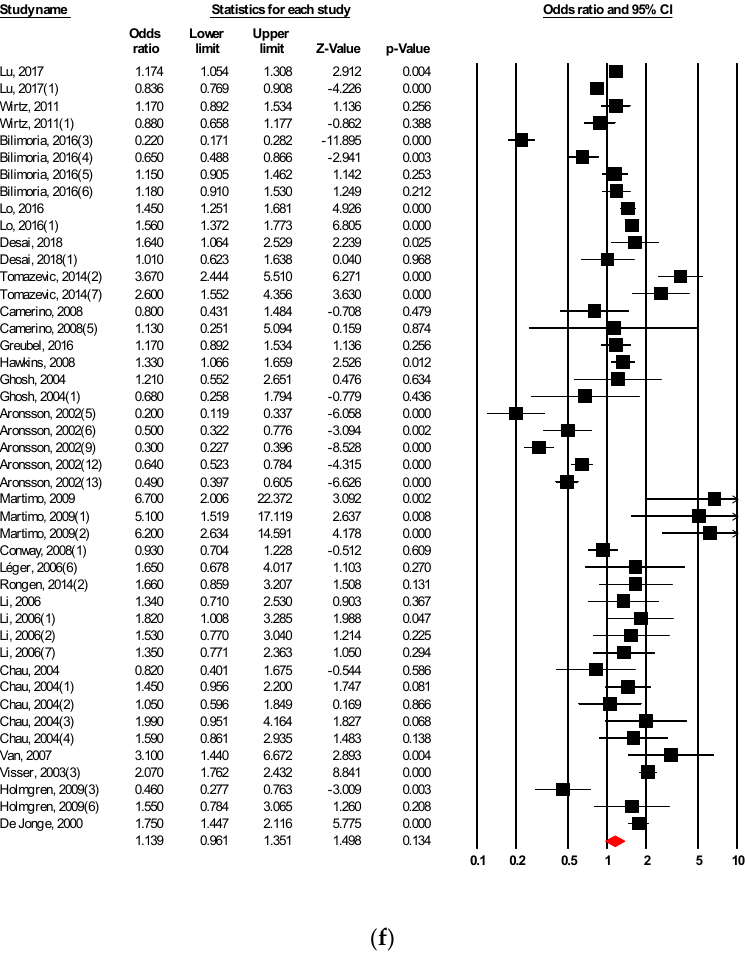
Figure 2. Forest plot of ( a ) career motivation (CM), ( b ) employee attendance (EA), ( c ) employee recruitment (EC), ( d ) employee retention (ET), ( e ) organisational commitment (OC), and ( f ) productivity (PR). Note: In this forest plot, the midpoint of a square provides the odds ratio estimated for the study. The area of the square is proportional to the weight of the study in the meta-analysis. The width of the horizontal line shows the confidence interval. The centre of the diamond represents the overall odds ratio, and its width refers to the confidence interval.